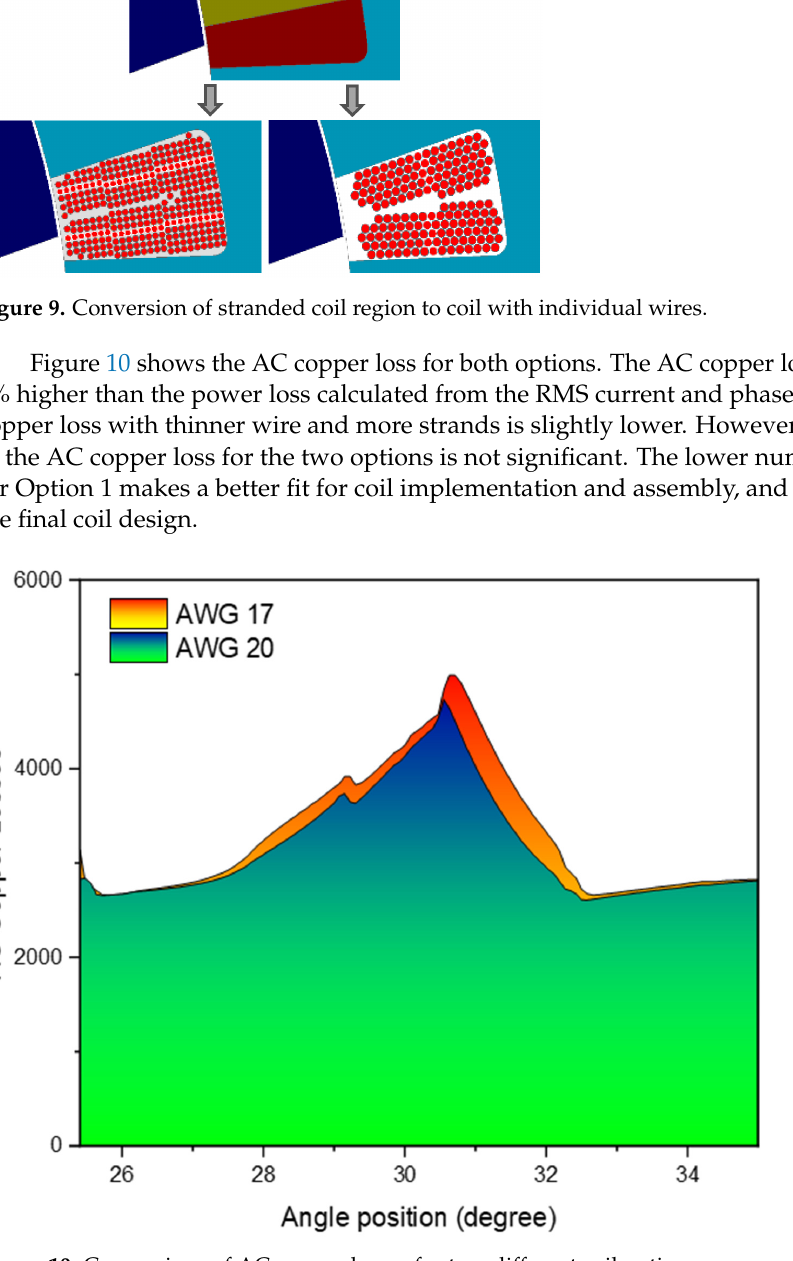
Figure 10. Comparison of AC copper losses for two different coil options.